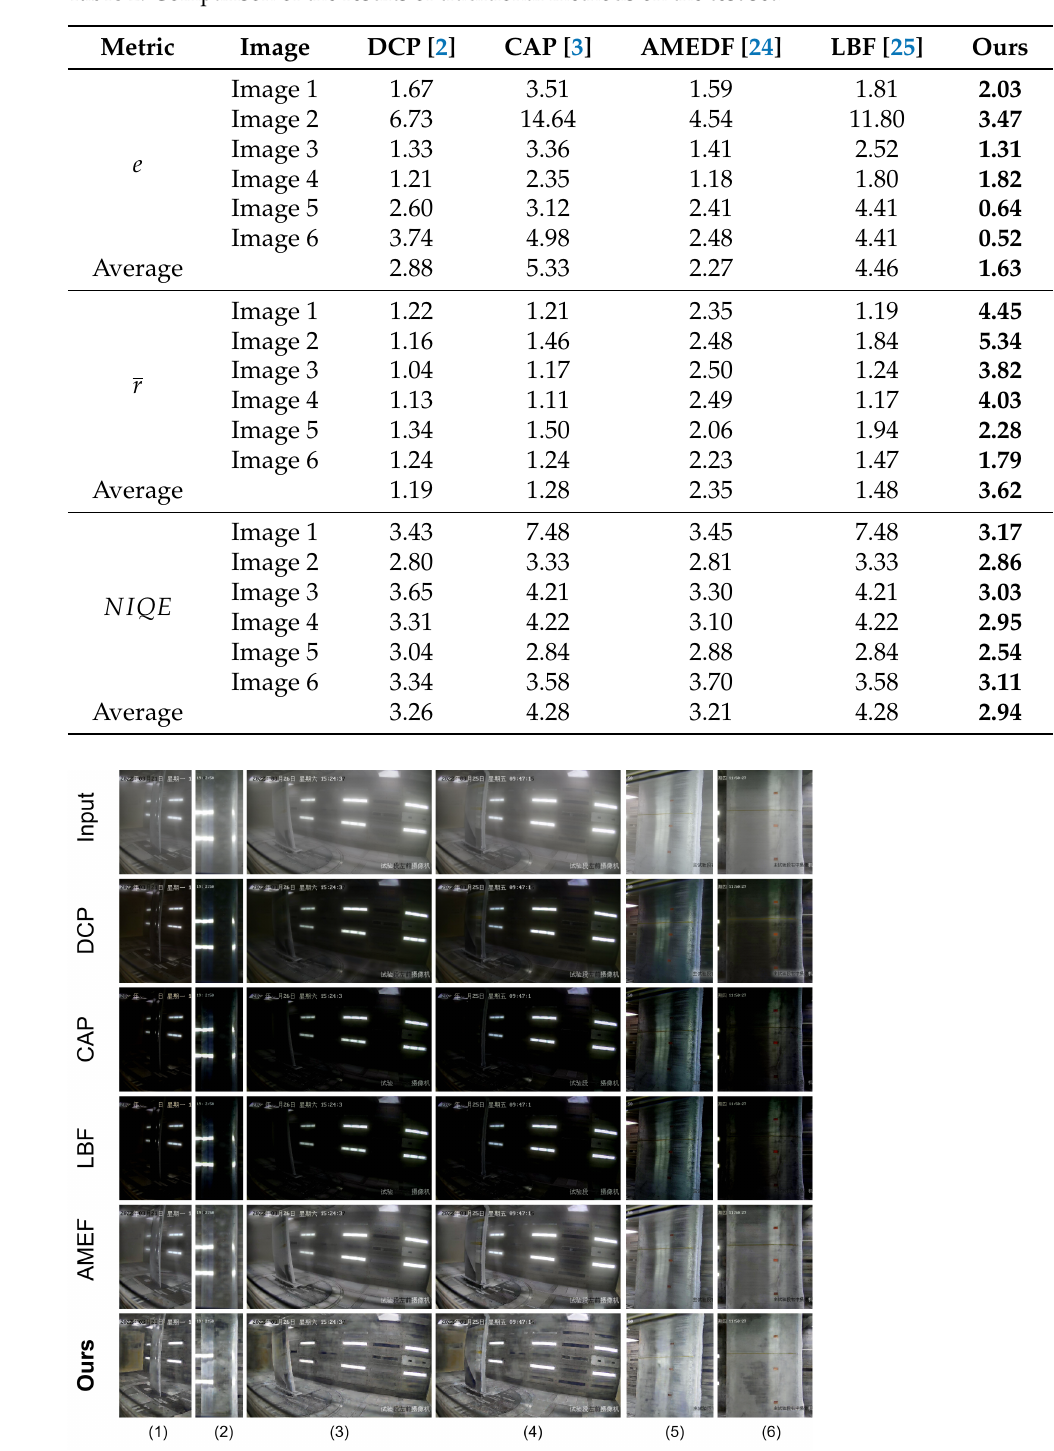
Table 2. Comparison of the results of traditional methods on the test set.